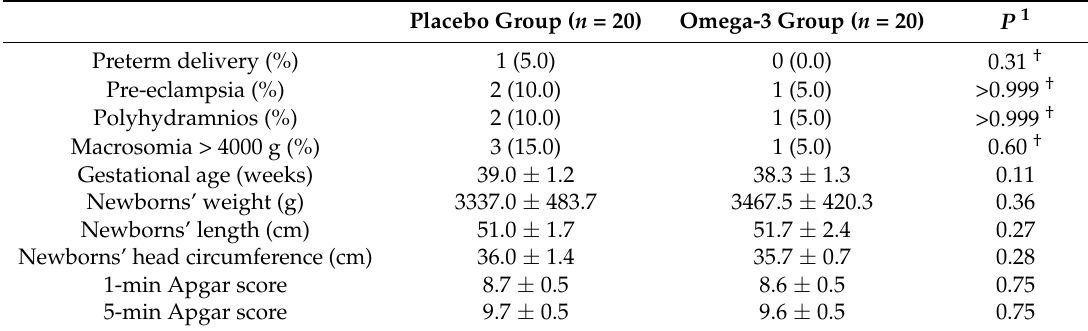
Table 4. The association of omega-3 supplementation with pregnancy